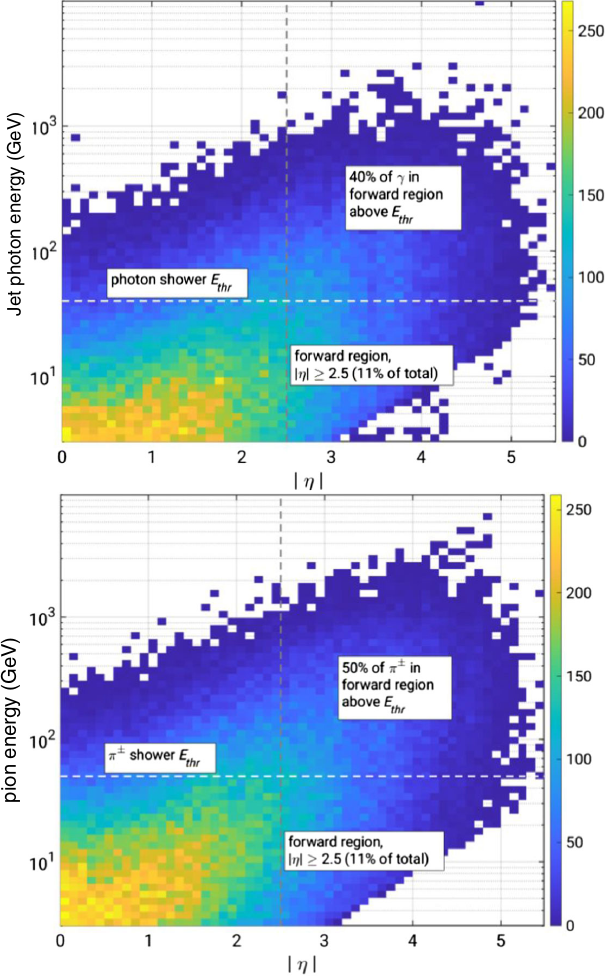
FIG. 34. Top: Jet photon energy distribution vs j η j with the forward region and energy threshold for ACE detection marked. Bottom: similar distribution for jet π (cid:2) . In both cases, the photons and pions are part of the 100 TeV PYTHIA 8 simulation introduced in Fig. 32 above. Color bars refer to counts per histogram bin.